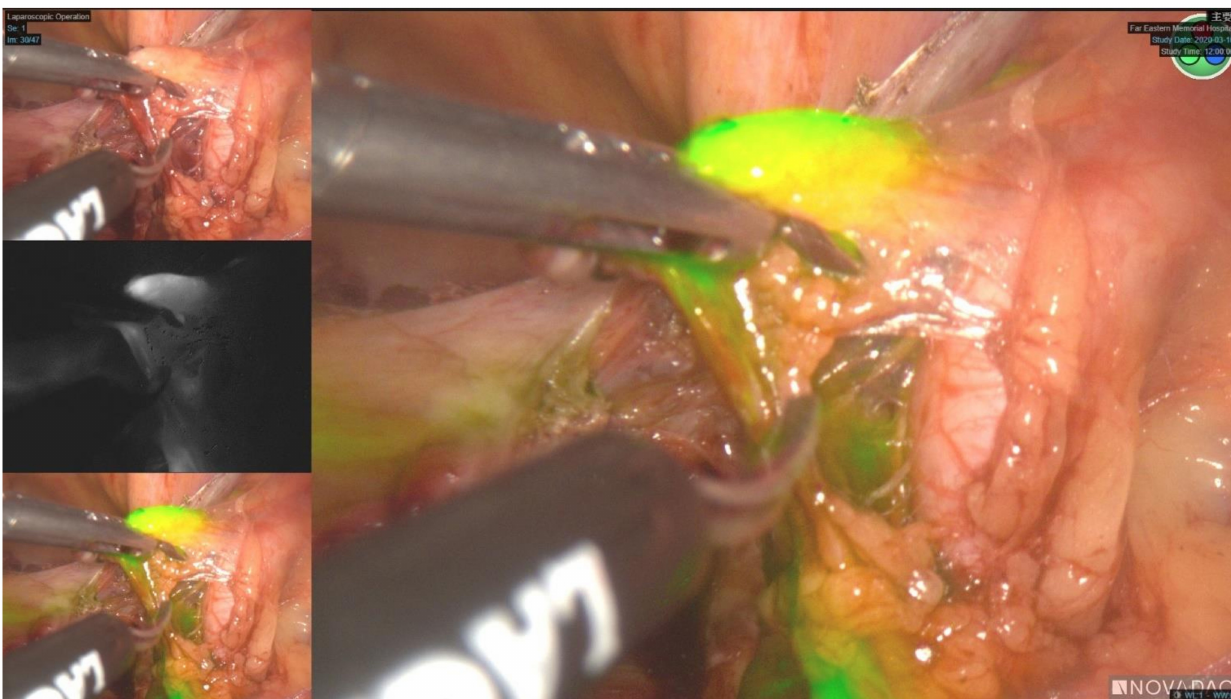
Figure 1. Sentinel lymph node mapping over right